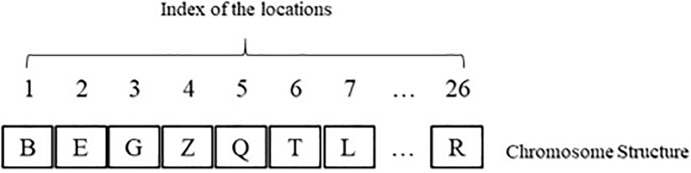
Solution encoding.